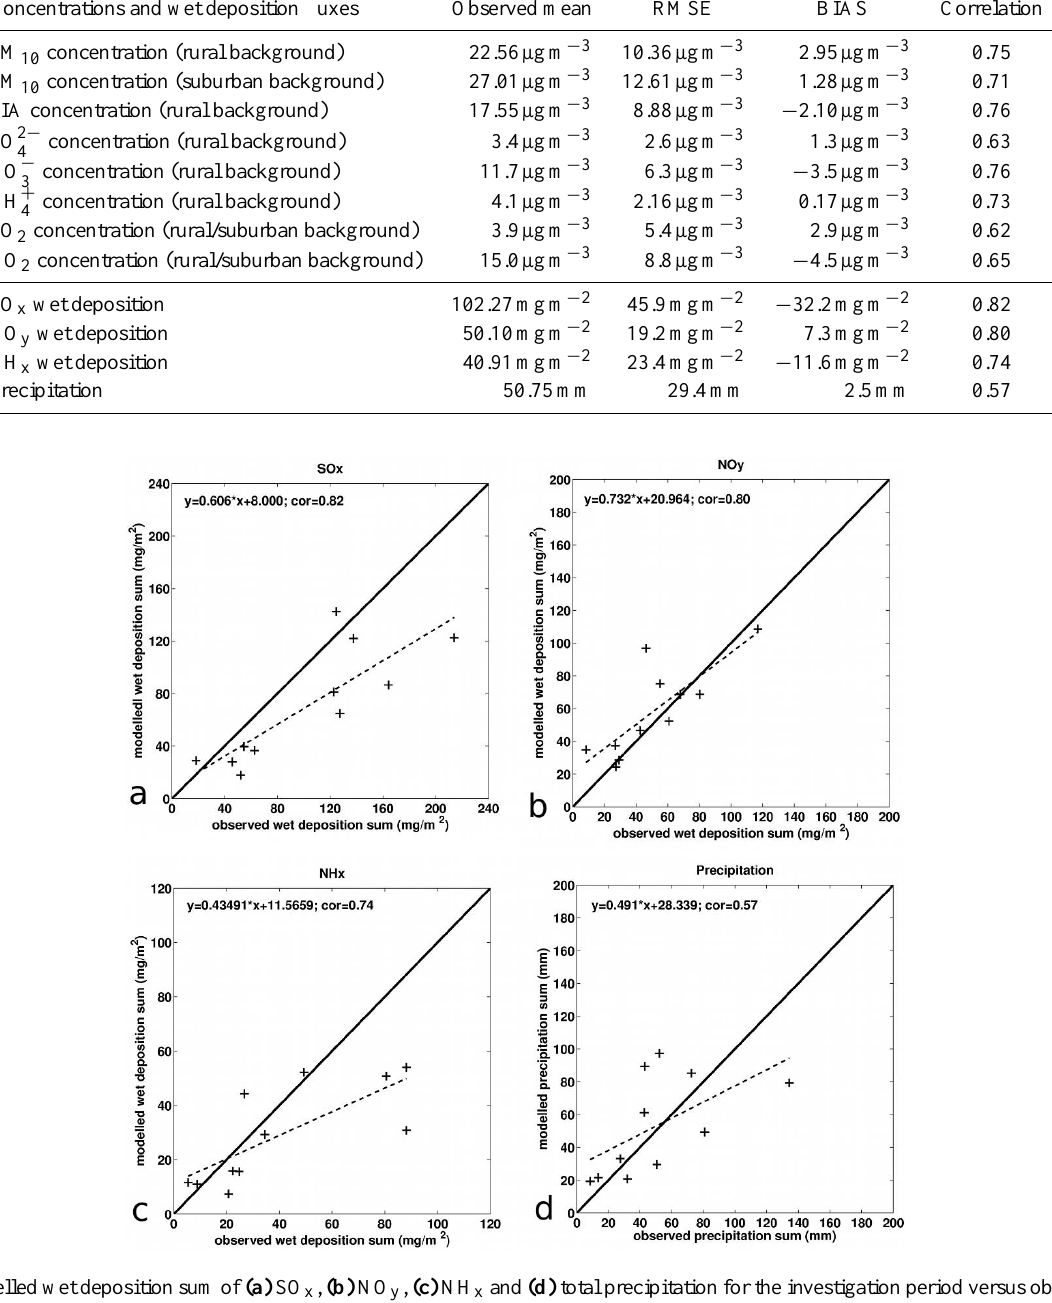
Fig. 7. Modelled wet deposition sum of (a) SO x , (b) NO y , (c) NH x and (d) total precipitation for the investigation period versus observations at 11 UBA